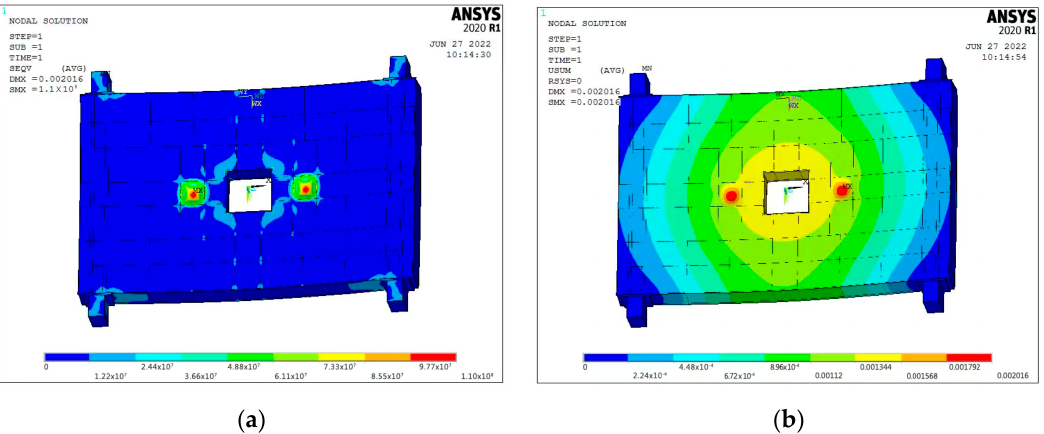
Figure 7. Large body skeleton stress cloud and skeleton displacement cloud. ( a ) Large body skeleton stress cloud; ( b ) large body skeleton displacement cloud.